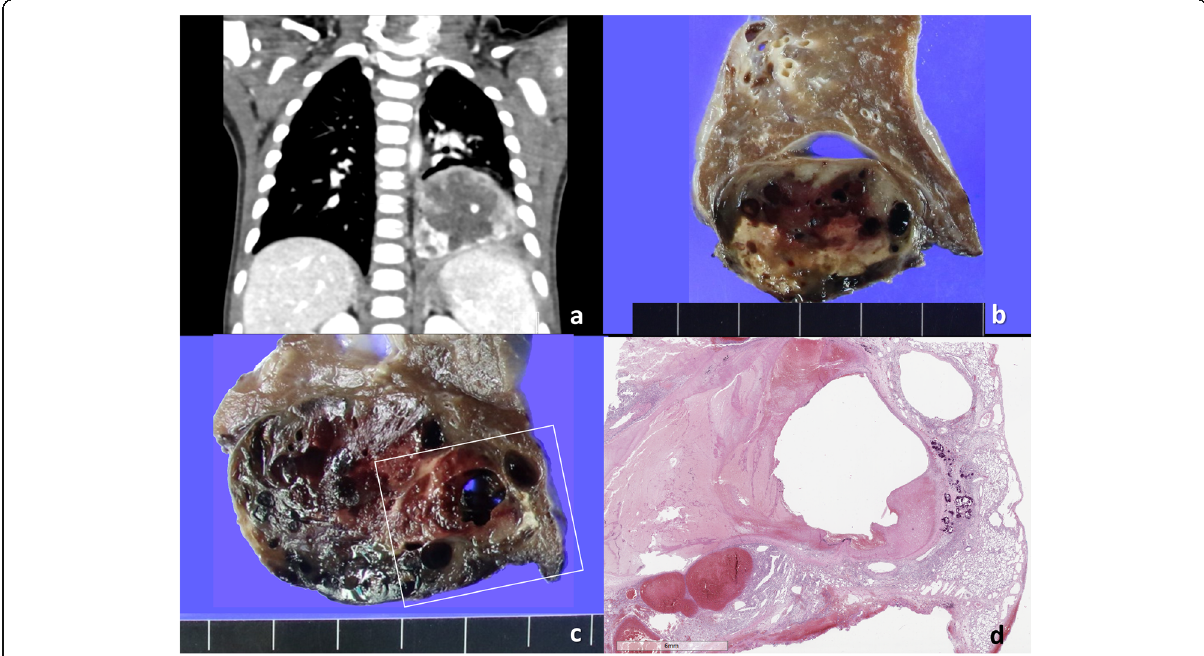
Fig. 2 a Chest CT of the ETV6-NTRK3 fusion-positive inflammatory myofibroblastic tumor (IMT) reveals a heterogeneously enhancing tumor in the left lower part of the thorax. b The mass arises from extrapulmonary sequestration, supplied by the left phrenic artery, which is separated from the lower lobe of the lung. c The cut surface of the tumor is hemorrhagic and has congested large vessels. d This is the microscopic picture of the squared part of Fig. c . It is a well-encapsulated, but partly adhered to the lower lobe of the left lung. The tumor pushed the left lower lobe of the lung. Hemorrhage was developed by previous embolization of large vessels of the sequestrated lung, under the impression of arteriovenous